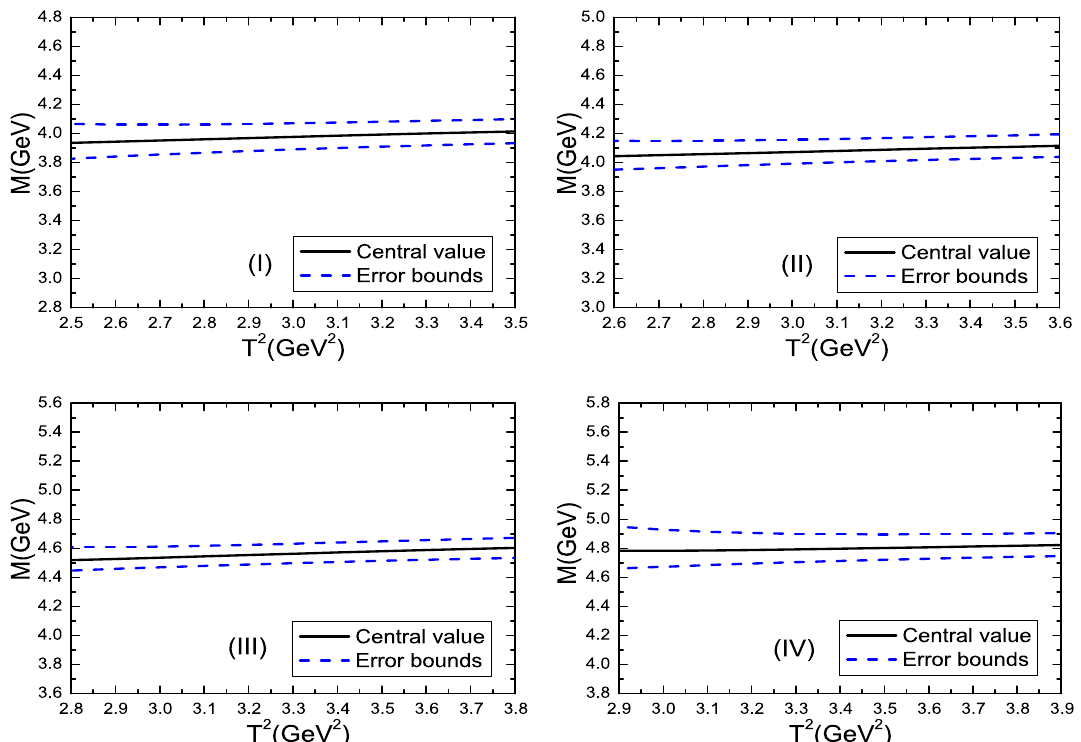
Fig. 3 The masses of the charmed pentaquark states with variations of the Borel parameters T 2 for the parameters B , where the (I), (II), (III) and (IV) correspond to the quantum numbers ( uuuc ¯ u , 3